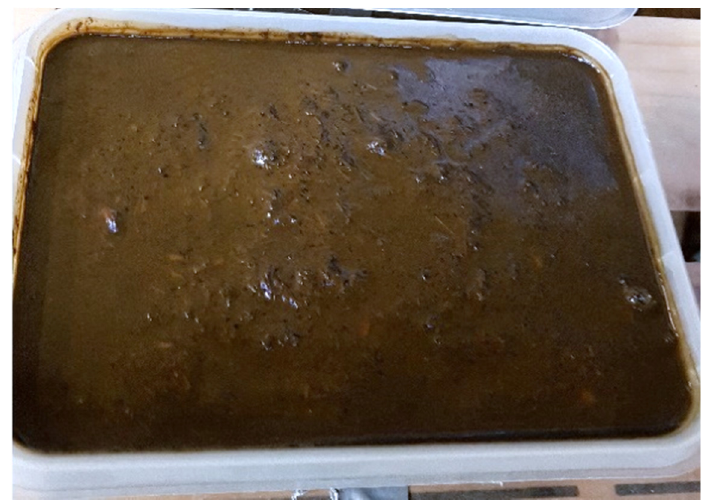
Figure A1. Control slurry at day 42, dried surface crust formation visible.